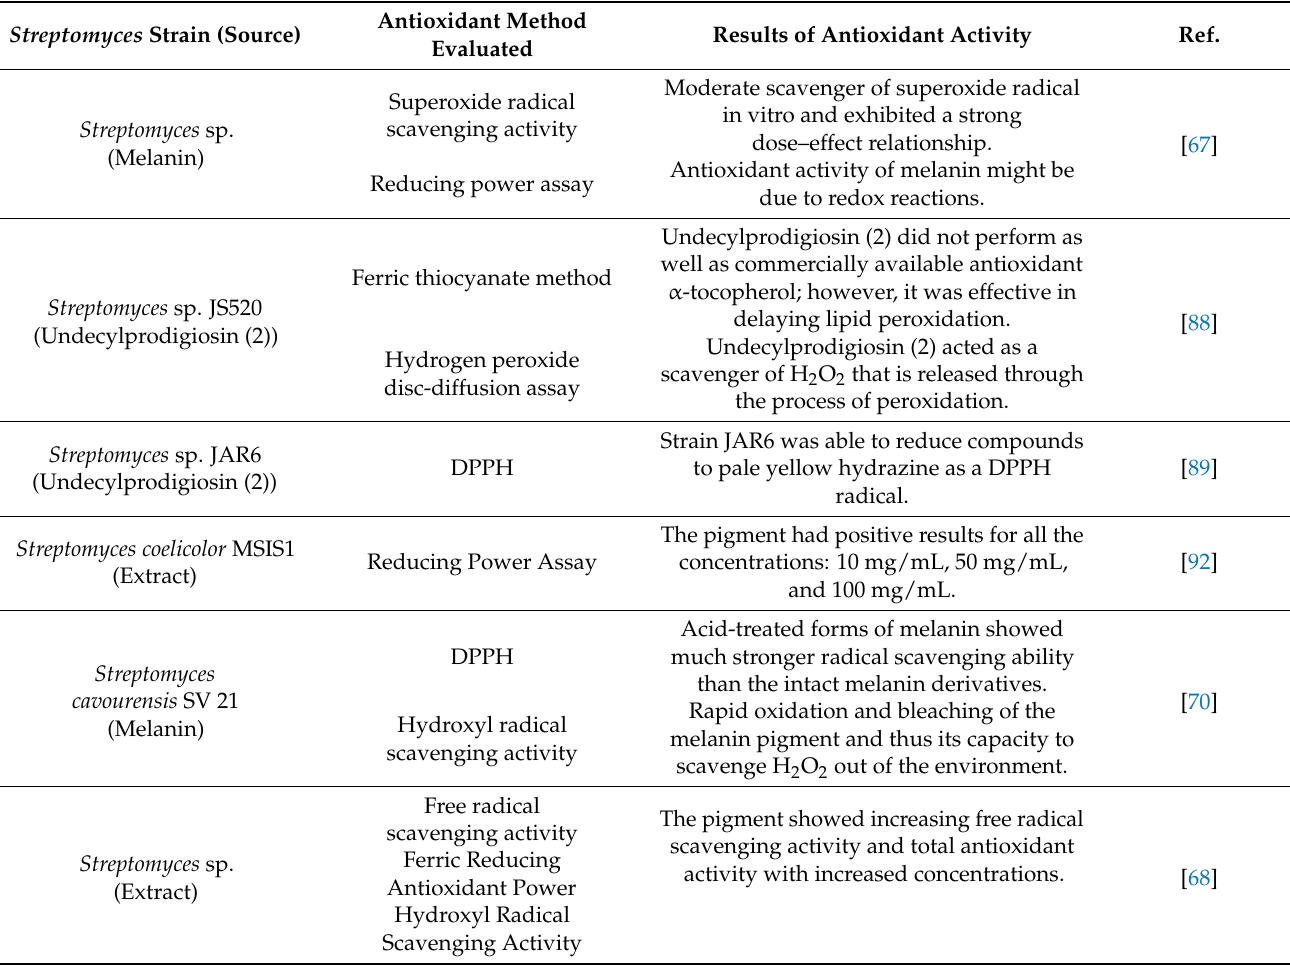
Table 9. Descriptive results of the Streptomyces strains with antioxidant activity